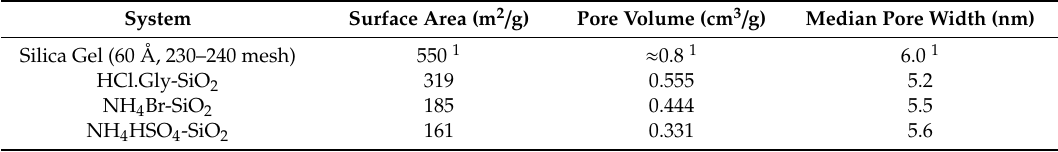
Table 4. Parameters of porous structure of the as-prepared catalyst and commercial silica gel support.